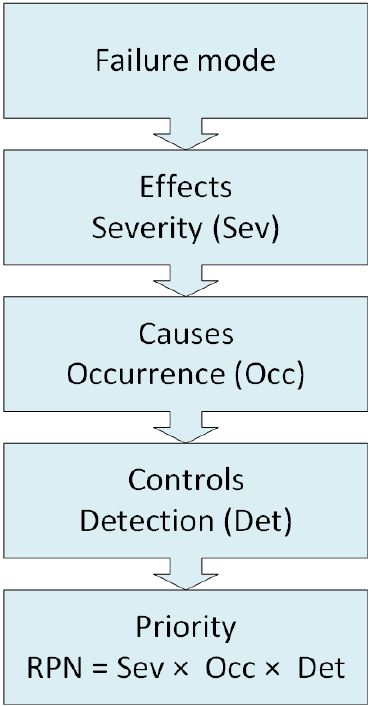
Figure 1. Important FMEA/FMECA tasks